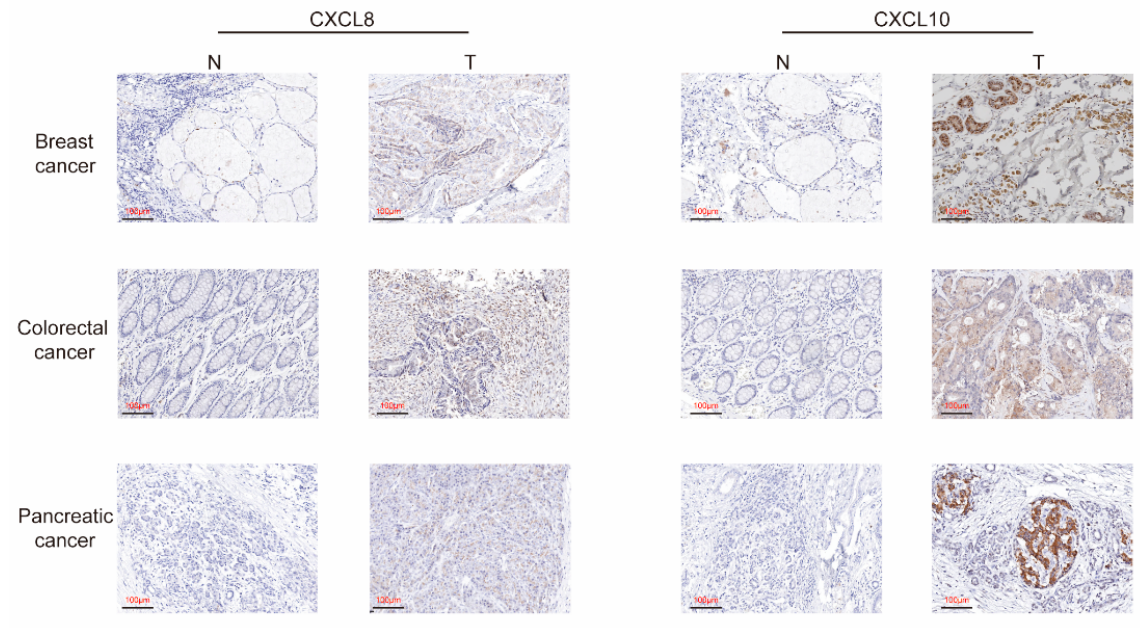
Figure 6. IHC analyses of CXCL8 and 10 in BRCA, COAD, and PDAC patients.